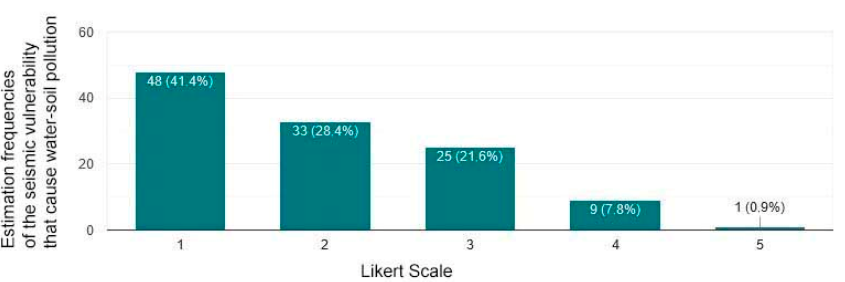
Figure 7. Seismic vulnerability of the WWTPs that cause water–soil pollution in the post-seismic period in Greece.